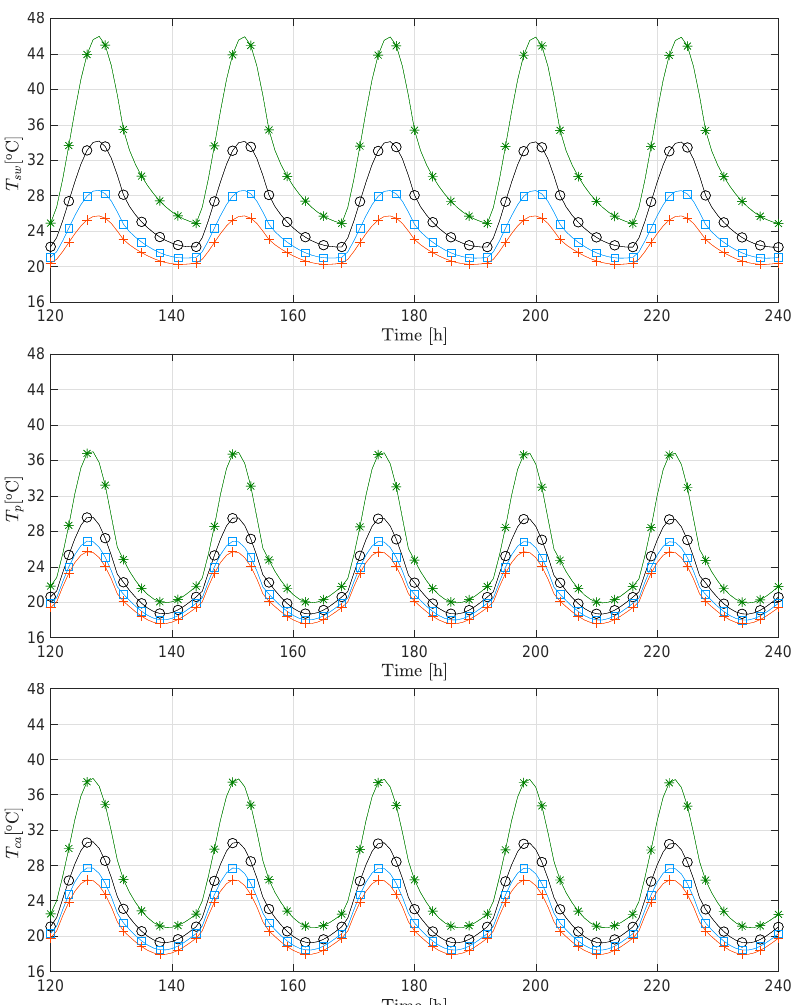
Figure 8. Facade surface temperature T sw (above), plant temperature T p (in the middle) and canopy air temperature T ca (below) distribution over time—sensitivity to leaf area index parameter, LAI : ( ∗ ) 1.5; ( ◦ ) 2.5; ( (cid:3) ) 3.5; (+)